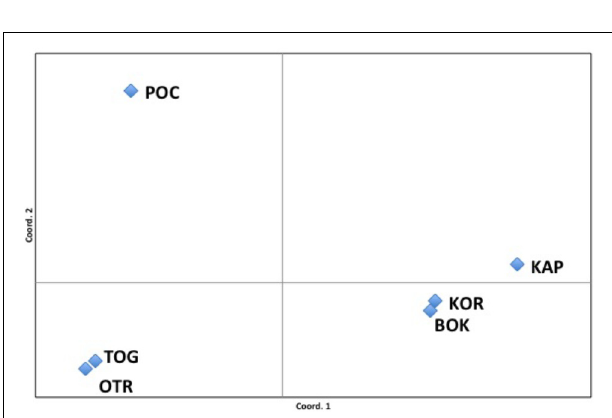
FIGURE 3 | Principal coordinates analysis (PCoA). F ST values among populations showed a variation of 96.81% explained by the two first